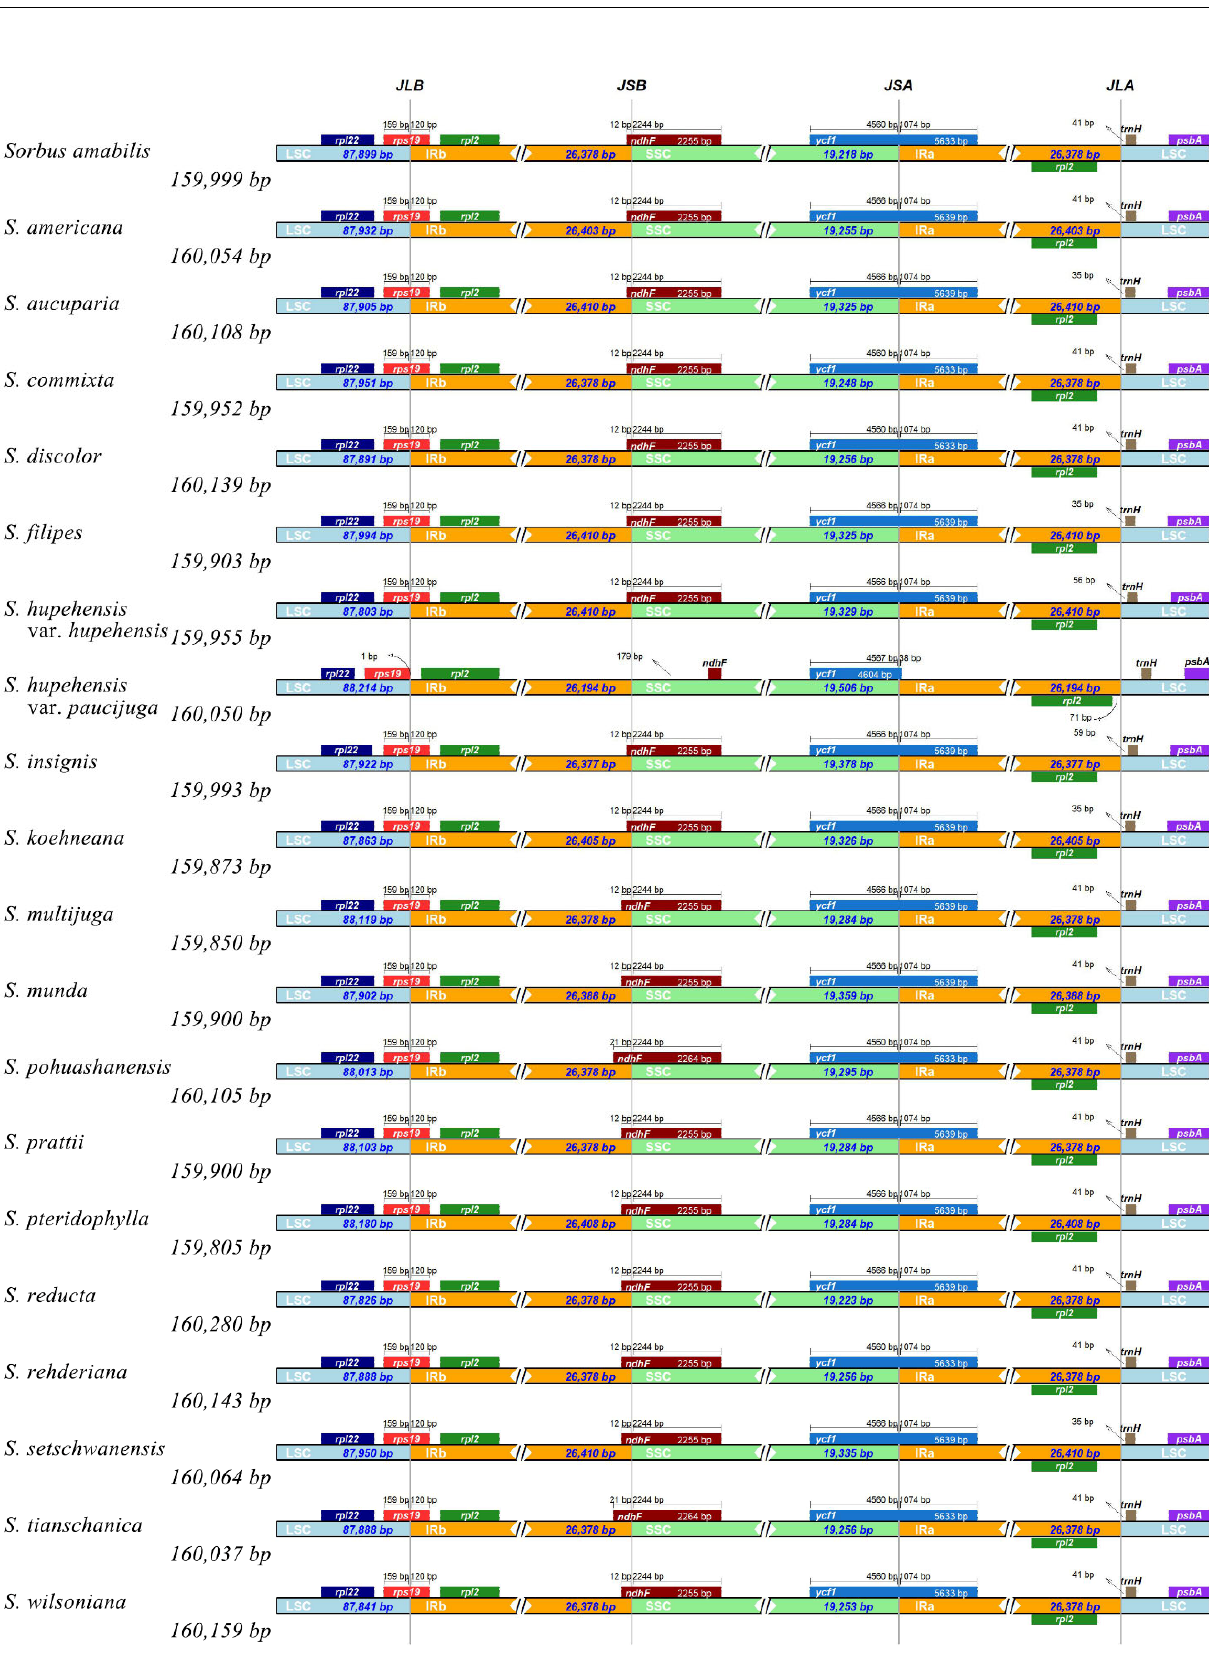
Figure 2. Comparison of the border regions of four chloroplast genome parts among Sorbus species. Repeat motifs in plastomes may induce recombination and genome rearrangement